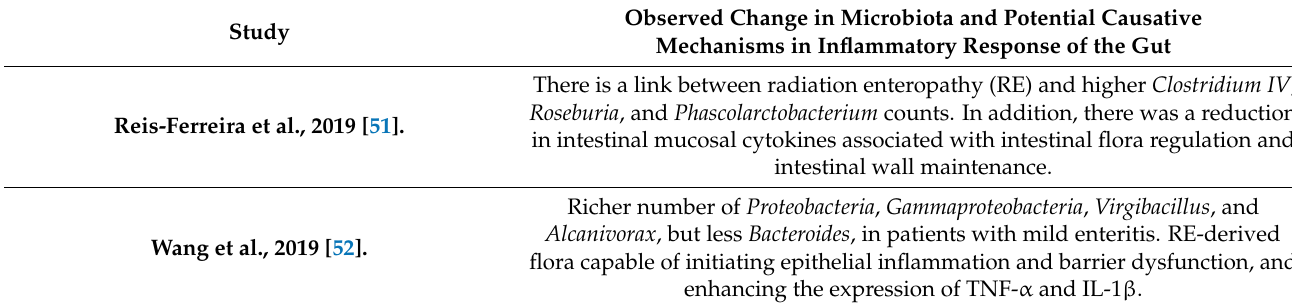
Table 3. Detailing the observed changes in microbiota following exposure to